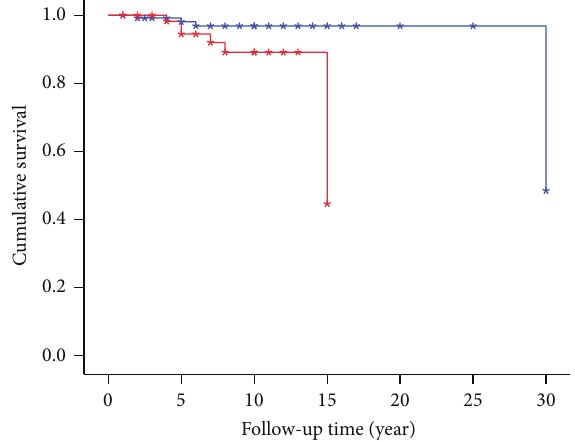
Figure 2: Survival curve in Parkinson’s disease patients with (red line) and without (blue line) any cardiovascular comorbidity ( 𝑝 value for log-rank test = 0.012).